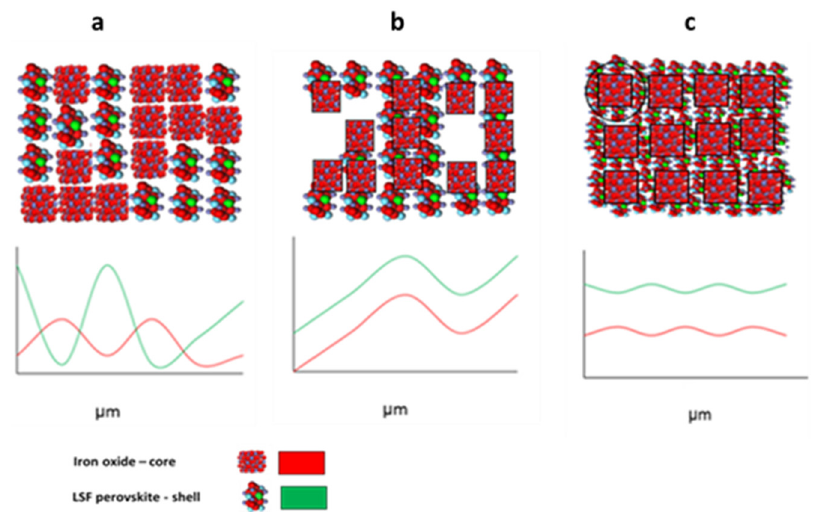
Scheme 3. Effect of particles morphology on the Fe (red) and La (green) concentration profiles. ( a ) separate segregated two phases, ( b ) partially covered core particles containing wide pores, ( c ) completely covered core